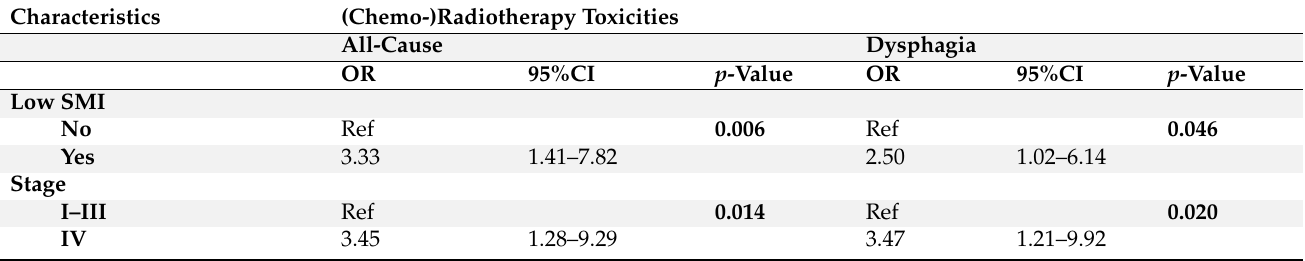
Table 6. Multivariable regression analysis for determining predictors for all-cause (C)RT toxicities and dysphagia